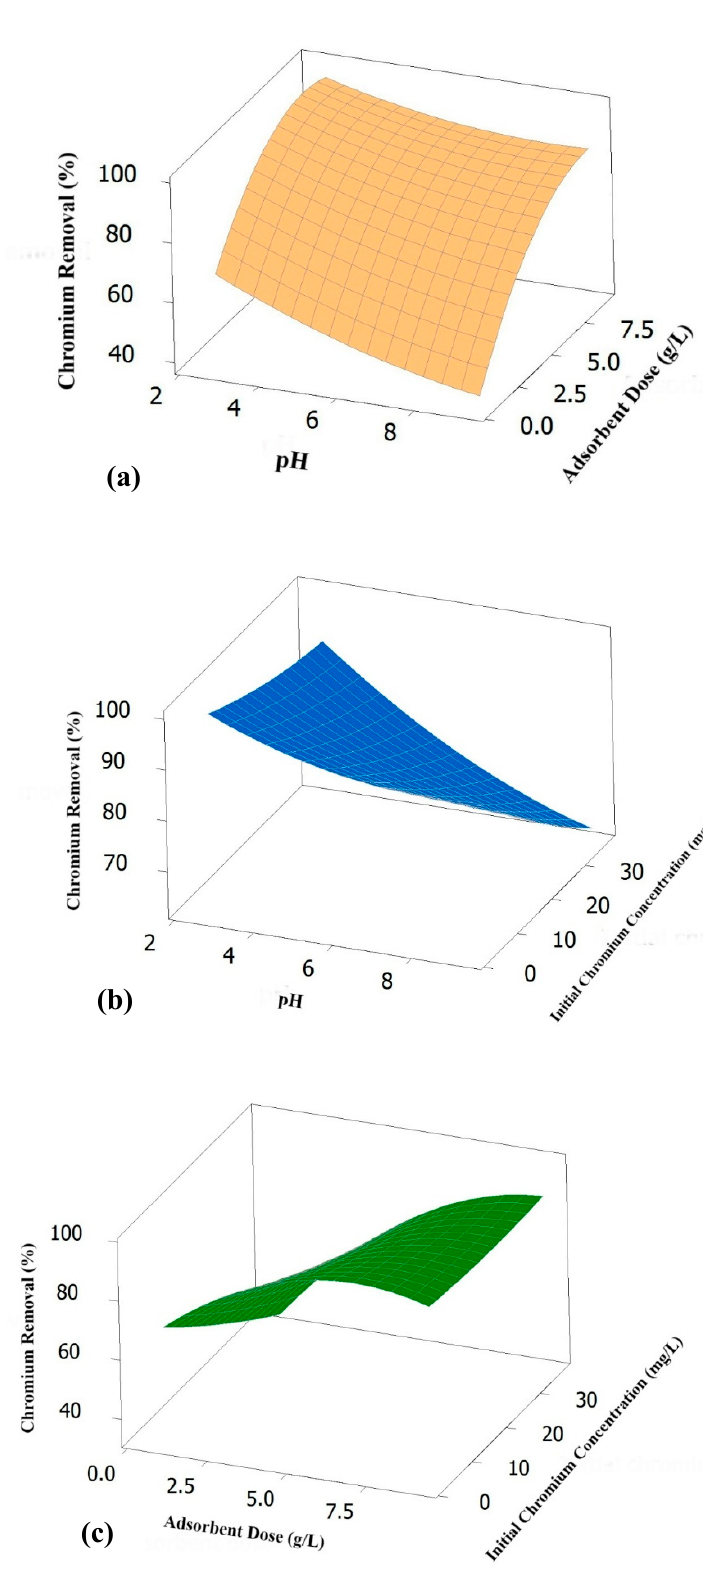
Figure 3. Response surface plots showing: ( a ) the e ff ects of pH (X 1 ), adsorbent dose (X 2 ), and their interaction on chromium RE, with constant initial chromium concentration (X 3 ); ( b ) the e ff ects of X 1 , X 3 , and their interaction on chromium RE (%); ( c ) the e ff ects of X 2 , X 4 , and their interaction on chromium RE (%).